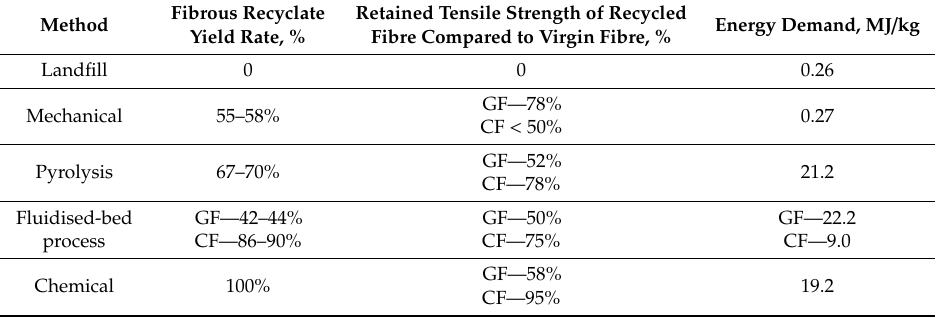
Table 1. Comparison of end-of-life (EoL) treatment methods for wind turbine blades. Source: based on data of